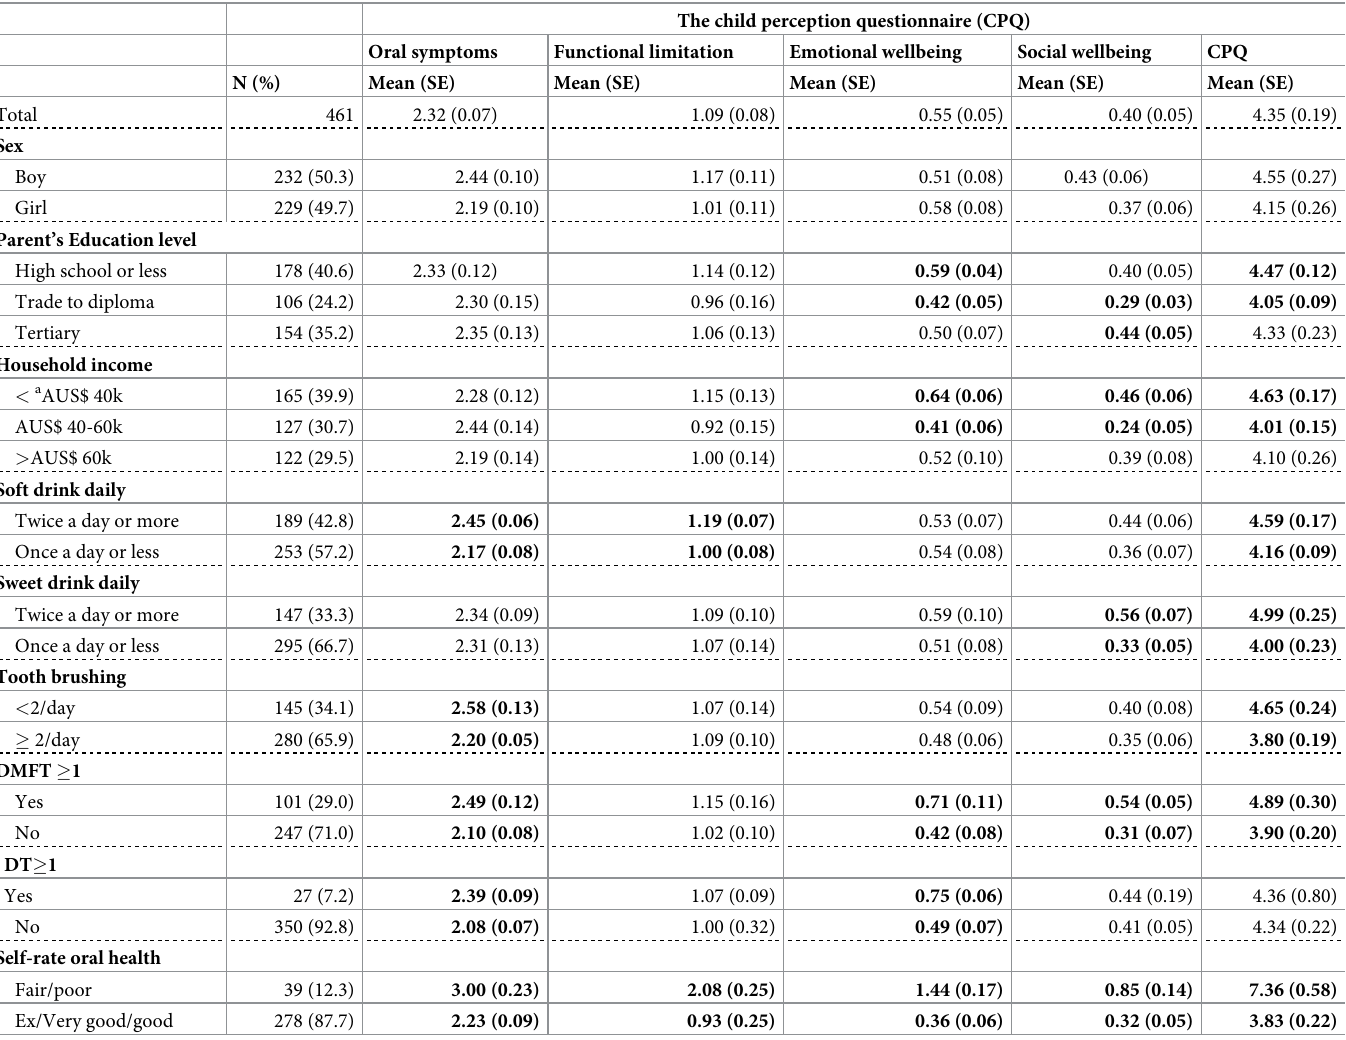
Table 8. Mean (SE) scores for 8-item CPQ and individual items by sample characteristics among children aged 11–13 years. The child perception questionnaire